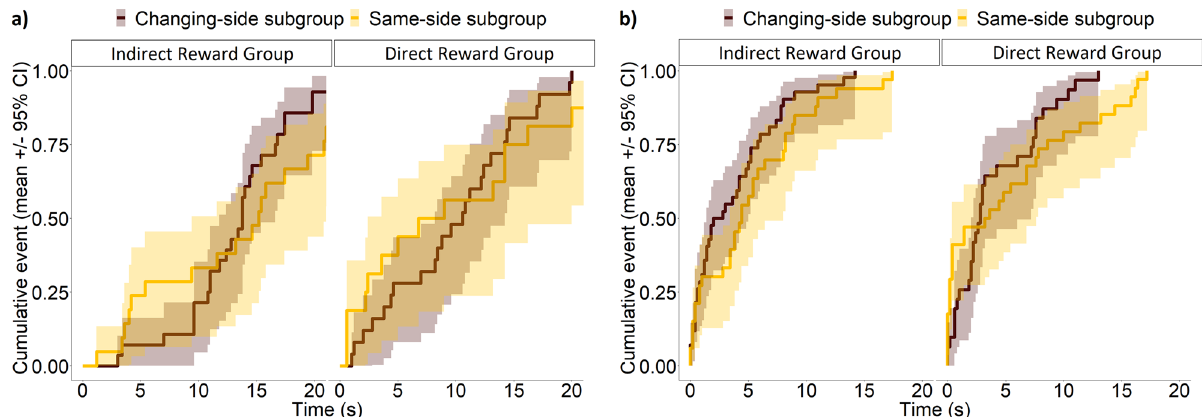
Figure 2. Latency to gaze at the UMO in the Test phase. Reward group and Location subgroup (and their interaction) had no effect on the latency ( a ) before or ( b ) after release.